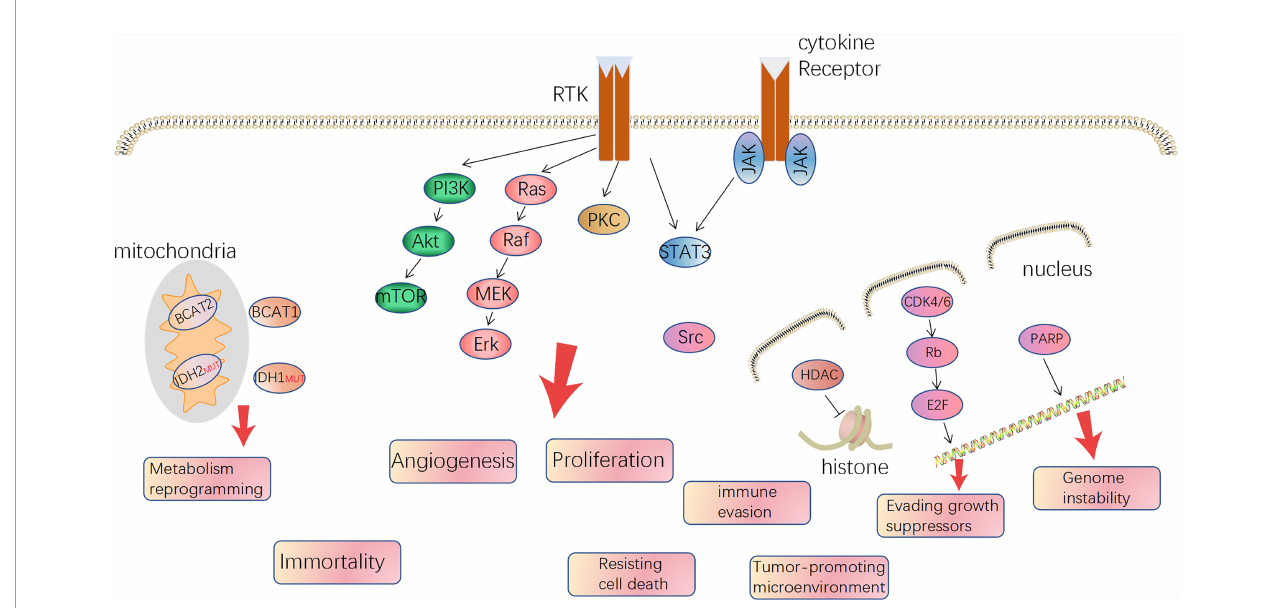
FIGURE 1 | The major druggable targets in glioblastoma and corresponded hallmarks of